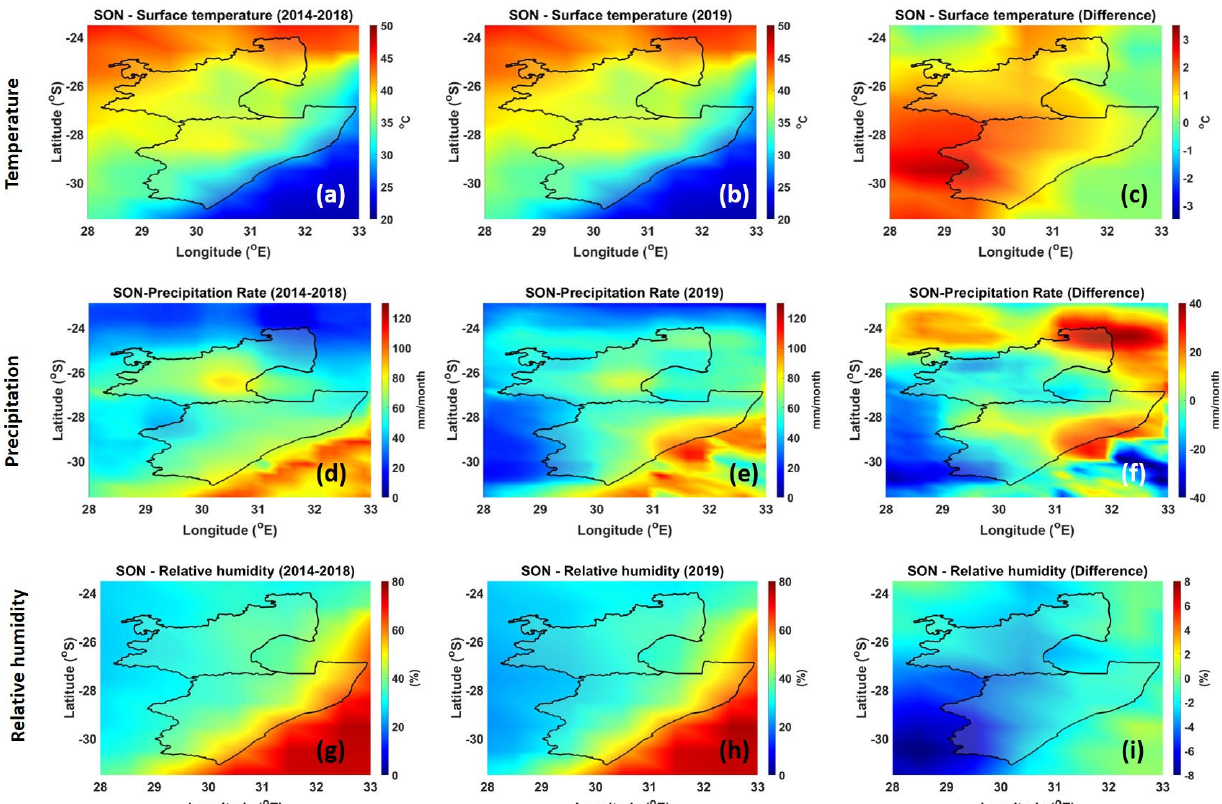
Figure 7. Spatial distribution of temperature ( a – c ), precipitation ( d – f ), and relative humidity ( g – i ) during the SON season.